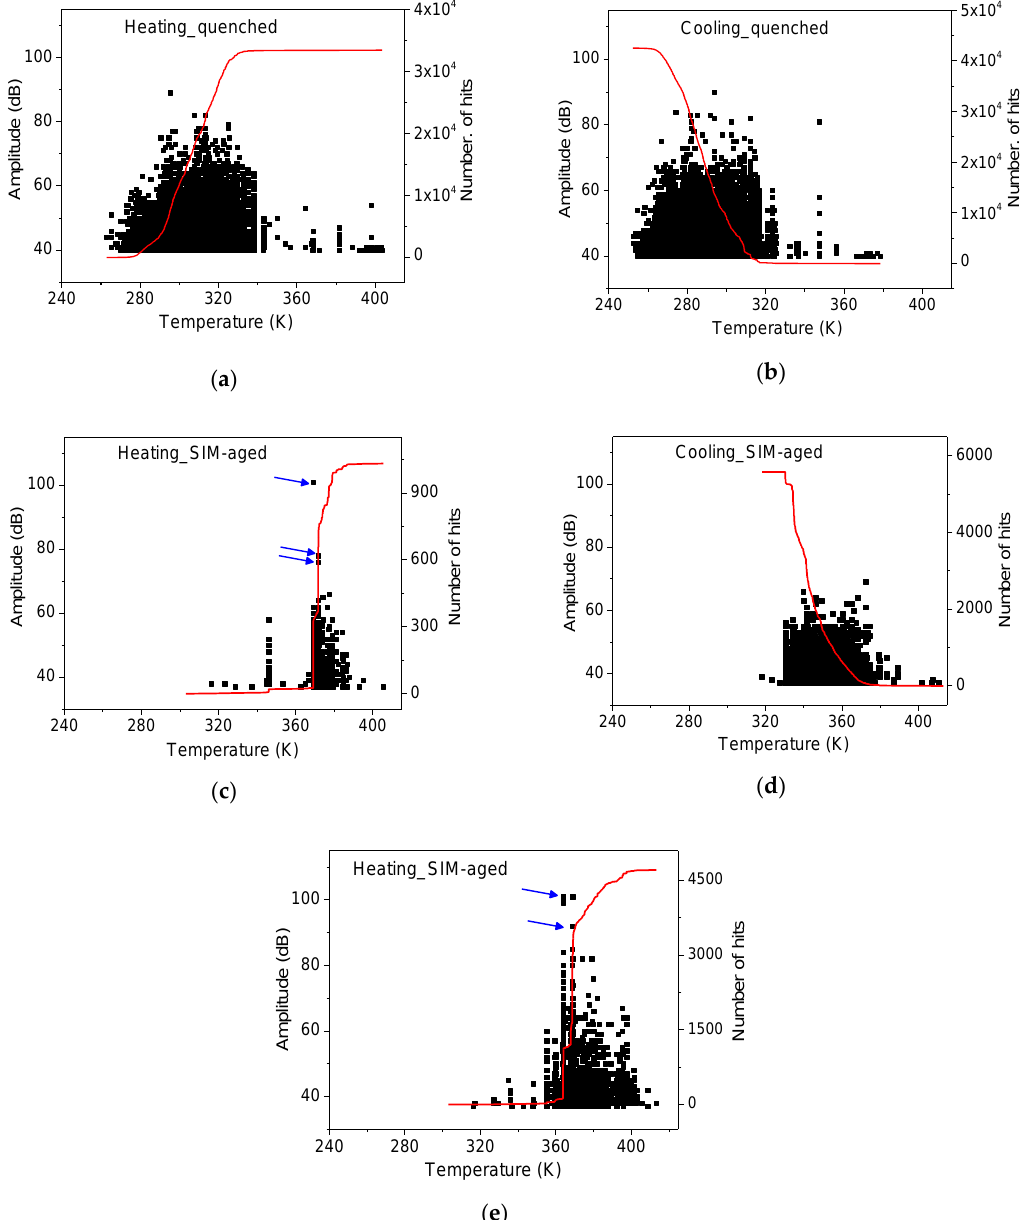
Figure 4. Acoustic emission signals during the transformation: heating and cooling for the quenched, ( a , b ) and SIM-aged ( c , d ) Ni 51 Fe 18 Ga 27 Co 4 single crystals. (Each point corresponds to an acoustic emission (AE) event, and the continuous line, indicating the transition, is the cumulative number of them.) In Figure 4 c , the three points, indicated by arrows, show the solitary high energy hits for the sample with m = 18 mg (see also below in Figure 8a), whereas Figure 4 e shows the same plot for the SIM-aged sample for heating with m = 47